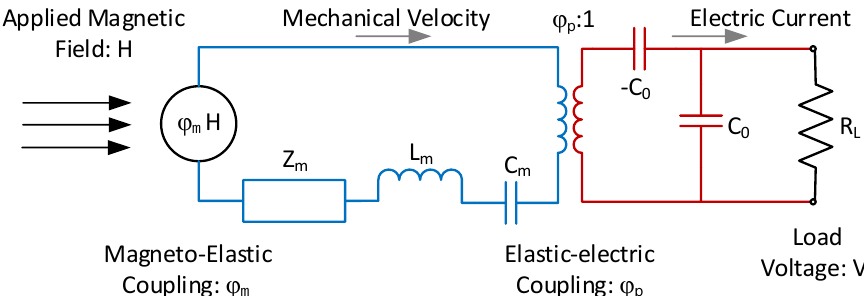
Figure 3. Magnetoelectric equivalent circuit with added load resistor. Adapted from [13].